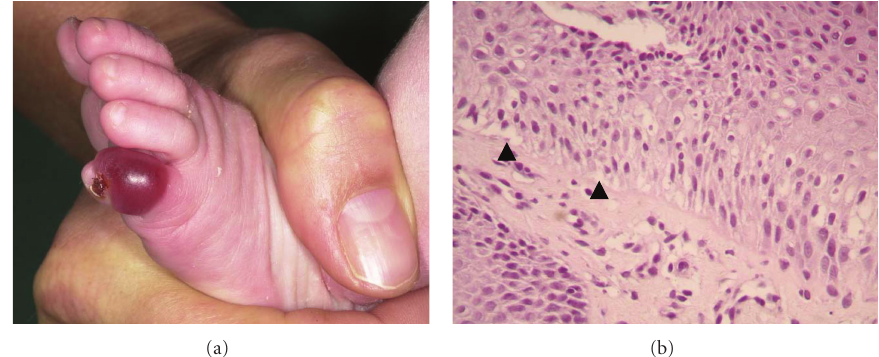
Figure 7: (a) Patient 3: haemorrhagic blister on the left little toe. (b) Histology of perilesional skin shows basal cell cytolysis (arrows) (Hematoxylin-eosin stain; original magnification: